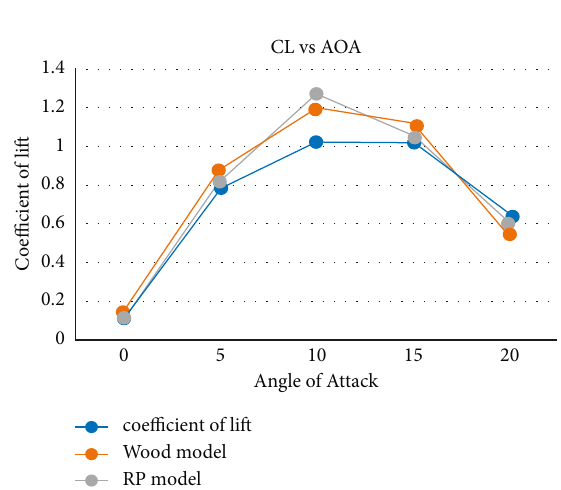
Figure 23: Plot between C